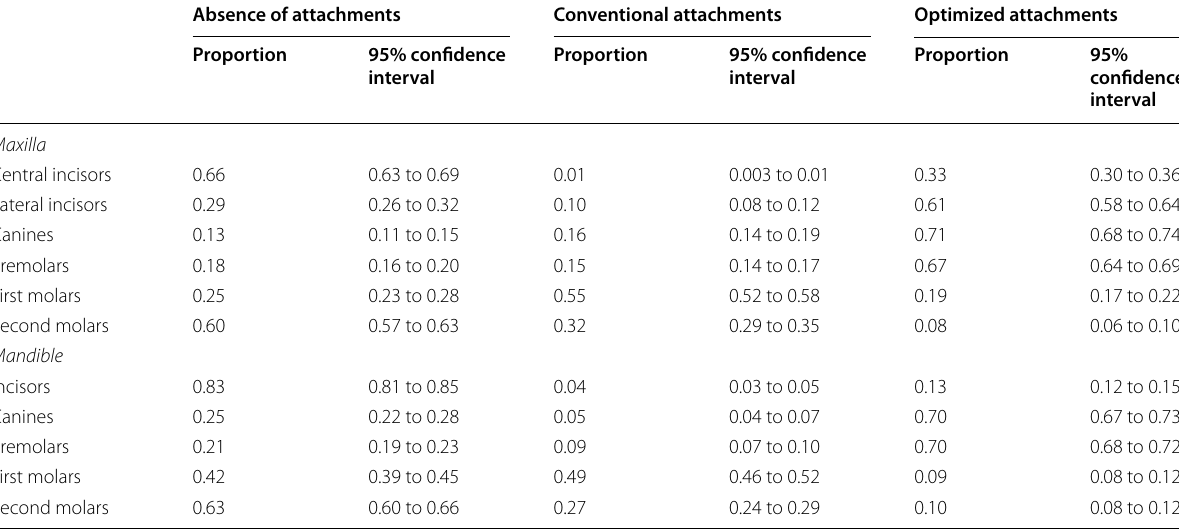
Table 2 Distribution of attachments stratified for group of teeth Absence of